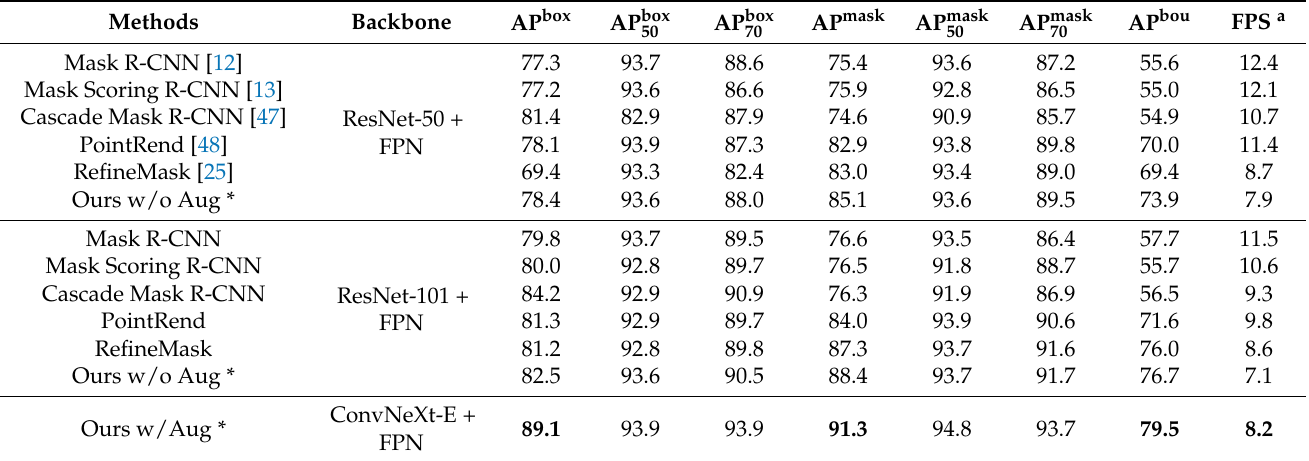
Table 1. Comparison with other methods on test